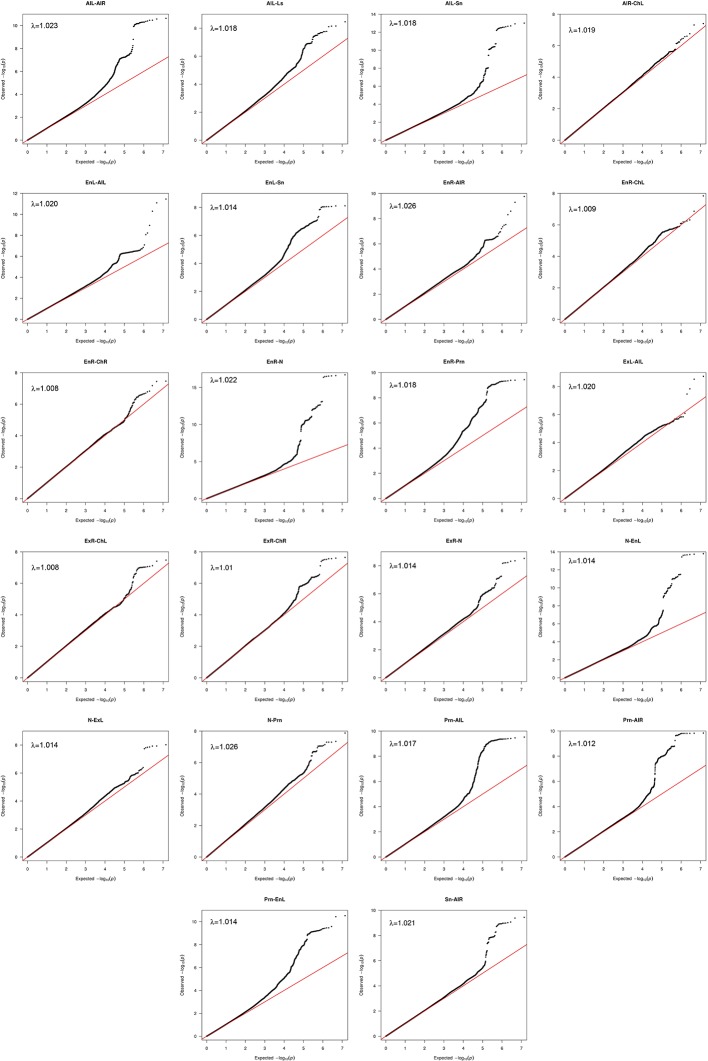
Quantile-Quantile plots and genomic inflation factors for 22 significant associated facial traits.